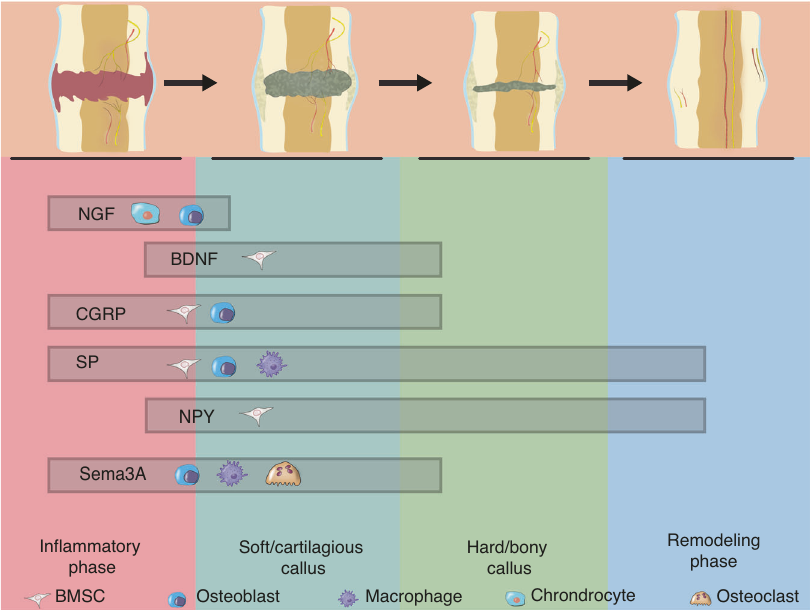
Fig. 6 Increased production of neuropeptides in bone healing. Various neuropeptides (NGF, BDNF, CGRP, SP, NPY, and Sema3A) are differentially distributed during the four corresponding phases (in fl ammatory, soft/cartilaginous callus, hard/bony callus, and remodeling) of bone healing with blood vessel and nerve regeneration. Cells (BMSCs, osteoblasts, macrophages, osteoclasts, and chondrocytes) listed in the relevant boxes have been identi fi ed as targets of speci fi c neuropeptides during bone